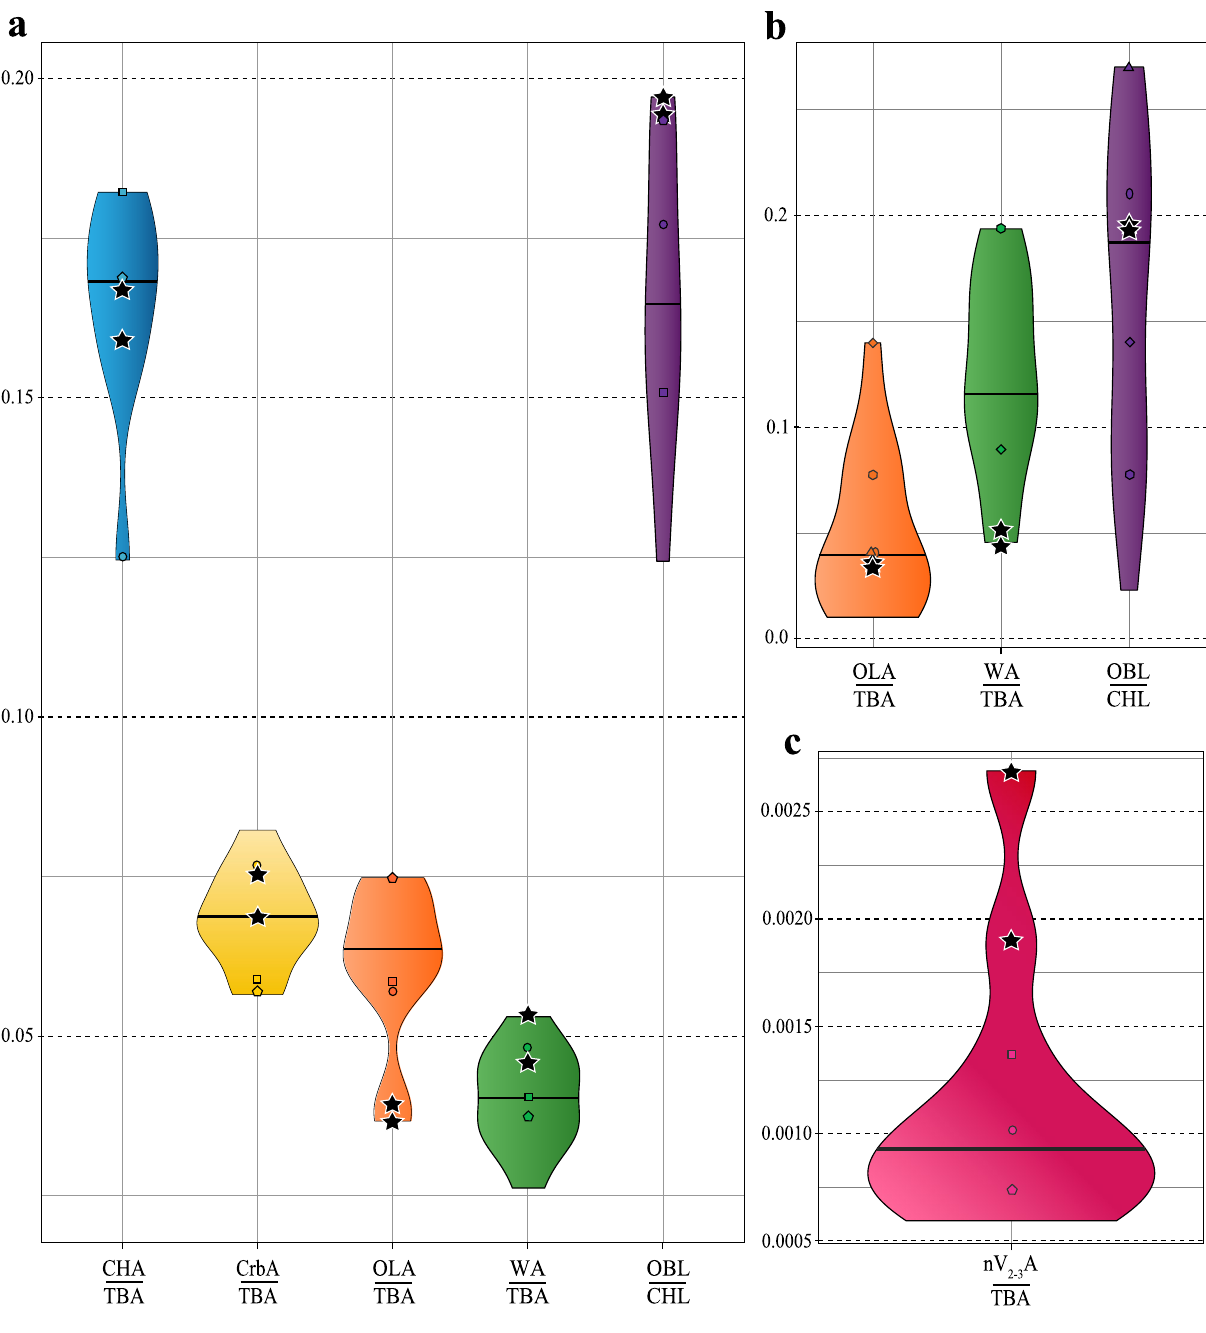
Figure 3. Violin plots showing the position of Sylviornis neocaledoniae (black star) relative to other Galliformes, with n = 11 ( a , c ) and large birds (body mass greater than 8.750 kg), with n = 9 for the ratio of wulst and n = 15 for the two other ratios ( b ), according to a series of ratios. Heavy black line indicates the median. Distribution of certain species: circle, Tetrao urogallus ; square, Mitu tuberosum ; pentagon, Odontophorus guttatus ; rhombus, Meleagris gallopavo ; triangle, Casuarius casuarius ; hexagon, Llallawavis scagliai ; ellipce, Pachyornis elephantopus . CHA cerebral hemisphere surface area, CHL cerebral hemisphere length, CrbA cerebellum surface area,